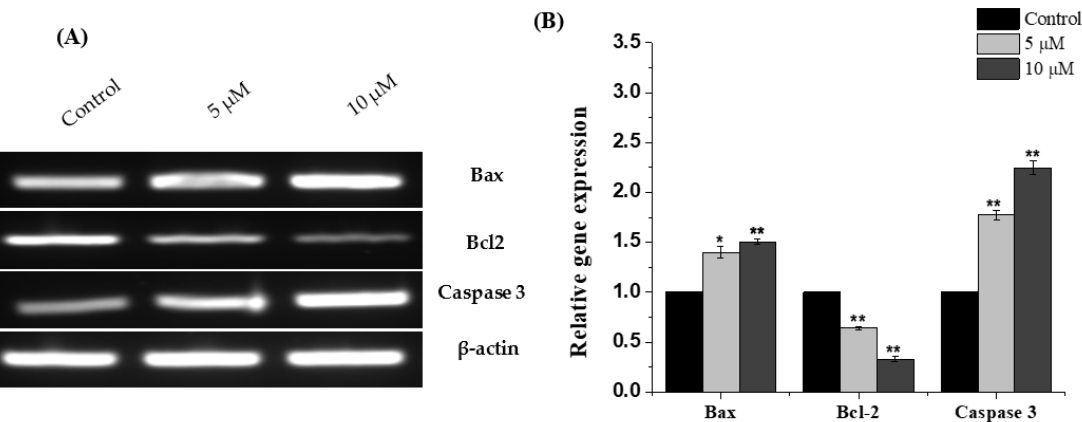
Figure 4. Effects of chlorojanerin on the mRNA expression of Bax, Bcl-2 and caspase-3 in human lung A549 carcinoma cells. ( A , B ) Fold-ratio: relative gene expression to control (control fold ratio: 1). * Mean values are significantly different from control * p < 0.05 and ** p < 0.01.